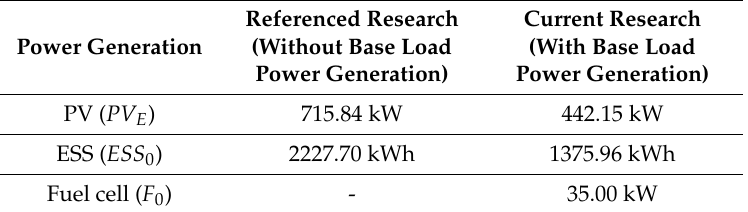
Table 2. Results of the system design according to the presence or absence of a base power source.